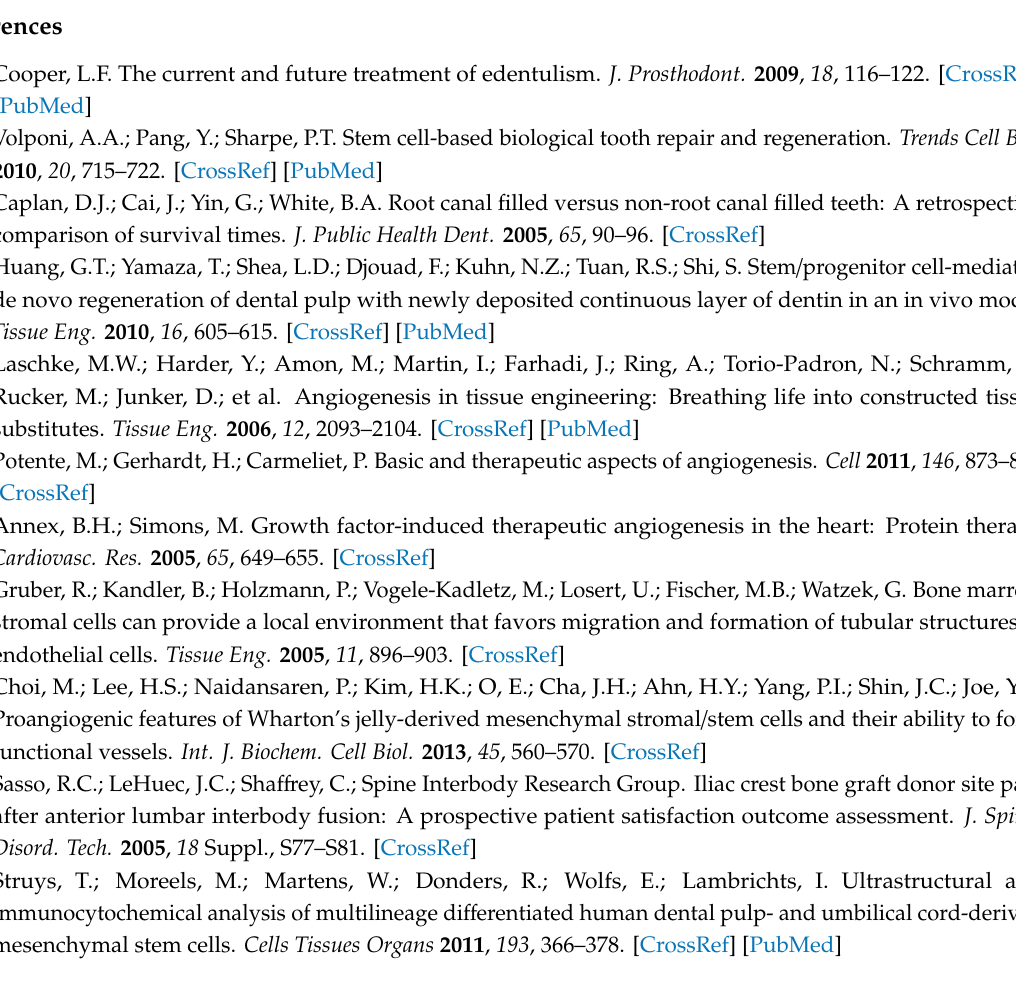
Figure S1: Quantification of the number of living cells at the time of conditioned medium collection, Figure S2: Quantification of density distribution of EVs from DPSCs and BM-MSCs isolated by di ff erential ultracentrifugation, Figure S3: Characterization of EVs isolated from DPSCs and BM-MSCs by di ff erential ultracentrifugation and their corresponding parental cells using (high-resolution) flow